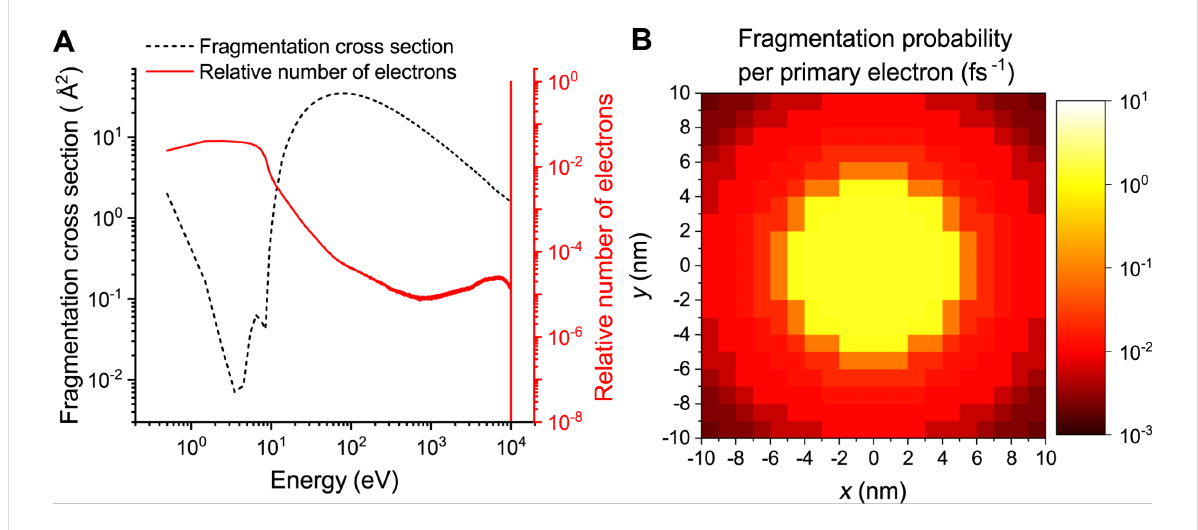
Figure 3: (A) Total electron impact fragmentation cross section of Pt(PF 3 ) 4 including DEA and DI contributions (dashed line) and the relative number of electrons of specific energy per PE [15] including SE and BSE (solid line). (B) Spatial distribution of the fragmentation probability of Pt(PF 3 ) 4